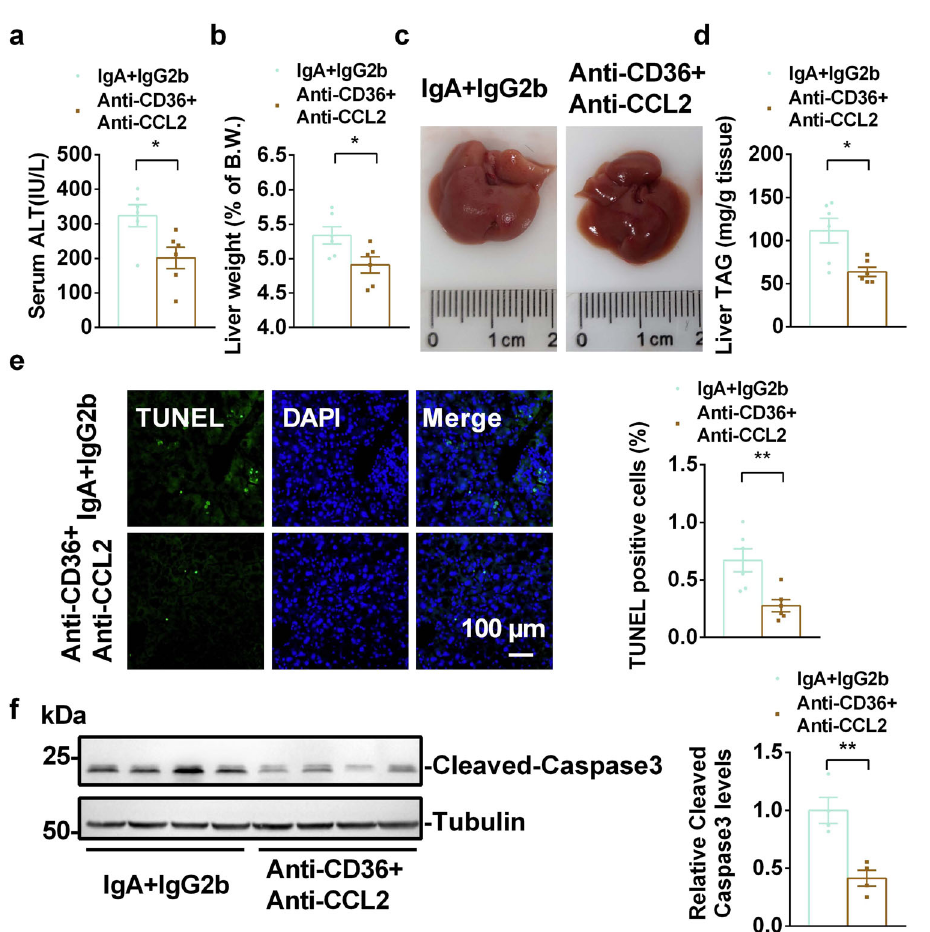
Fig. 6 Neutralization of CD36 and CCL2 ameliorates NASH progression in Mettl3- HKO mice. Mettl3- HKO mice at 8 weeks old were treated with a combination of anti-CD36 and anti-CCL2 antibodies (4 μ g/antibody/mouse, i.v.) or an equal amount of control antibodies (IgA and IgG2b) on day 1, 4, 7, and 8 after MCD feeding. Mice were killed on day 9 after MCD feeding. a Serum ALT activity ( n = 6 for each group; p = 0.0204). b Liver weights ( n = 6 for each group; P = 0.0325). c Representative liver pictures. d Liver TAG levels ( n = 6 for each group; P = 0.0108). e TUNEL-positive cells ( n = 6 for each group; P = 0.0059). f The cleavage of caspase3 was measured by immunoblotting, quanti fi ed by ImageJ, and normalized to Tubulin ( n = 4 for each group; P = 0.0043). The samples were derived from the same experiment and the blots were processed in parallel. n was the number of biologically independent mice. Data represent the mean ± SEM. Signi fi cance was determined by unpaired two-tailed Student ’ s t test analysis. * P < 0.05. ** P < 0.01. Source data are provided as a Source Data fi